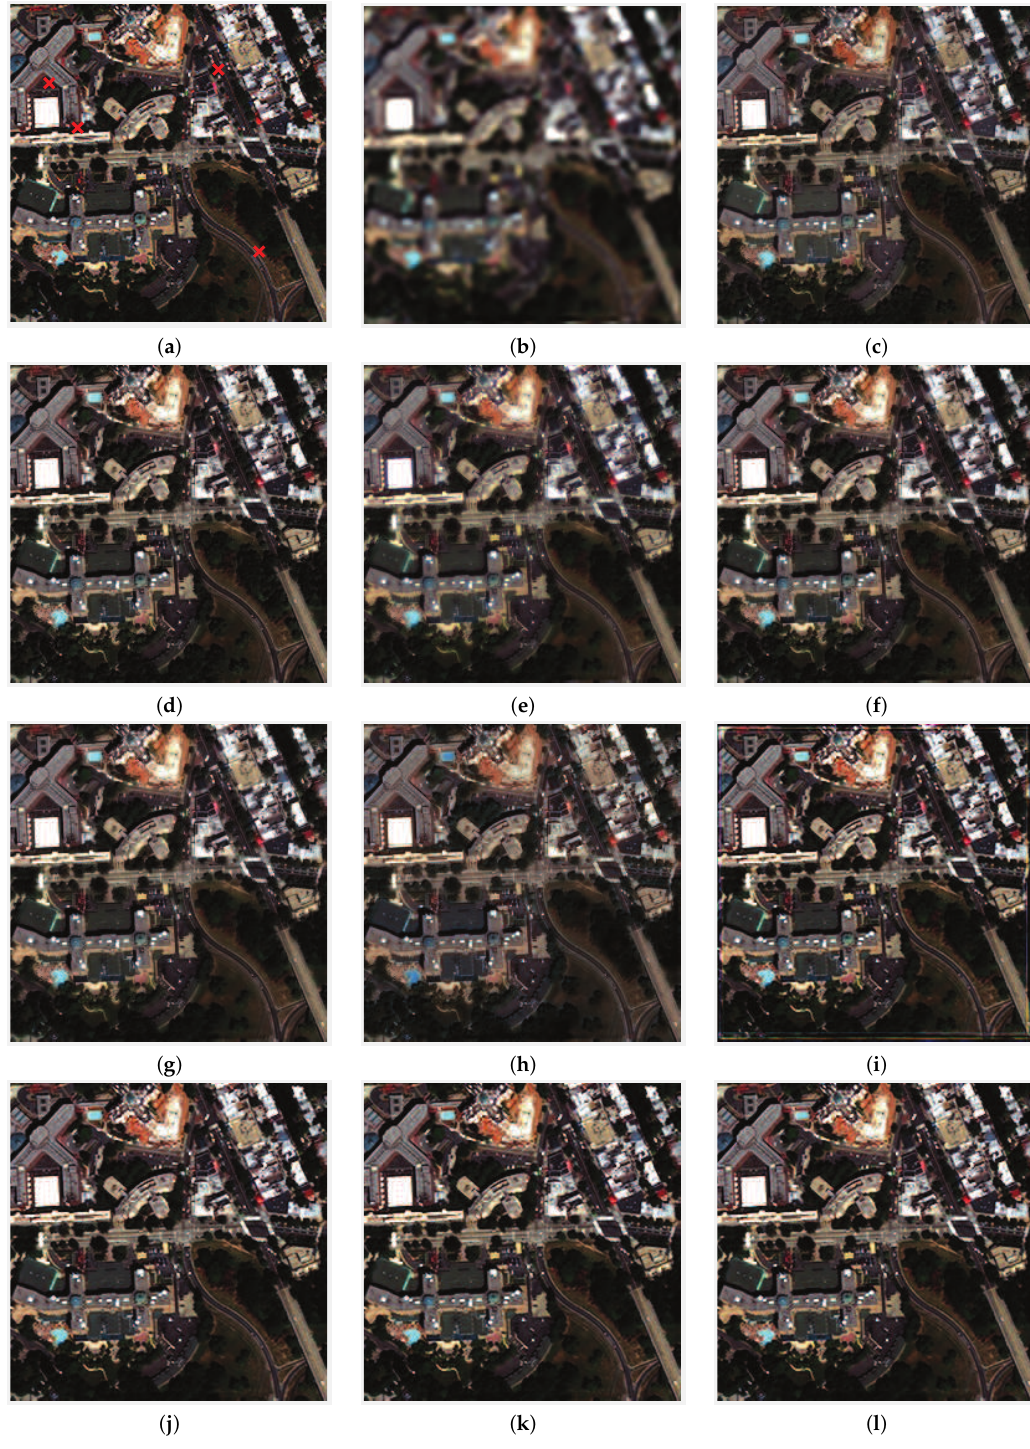
Figure 3. Pansharpening results for the WorldView-2 dataset: ( a ) ground truth; ( b ) polynomial kernel (EXP); ( c ) principal component analysis (PCA); ( d ) Gram–Schmidt adaptive (GSA); ( e ) partial replacement adaptive component substitution (PRACS); ( f ) à trous wavelet transform (ATWT); ( g ) Generalized Laplacian Pyramid with High-Pass Filtering (MTF-GLP-HPM); ( h ) coupled nonnegative matrix factorization (CNMF); ( i ) pansharpening CNN (PNN); ( j ) deep residual pansharpening neural network (DRPNN); ( k ) detail injection-based pansharpening CNN (DiCNN1); and ( l ) spectral-aware pansharpening neural network